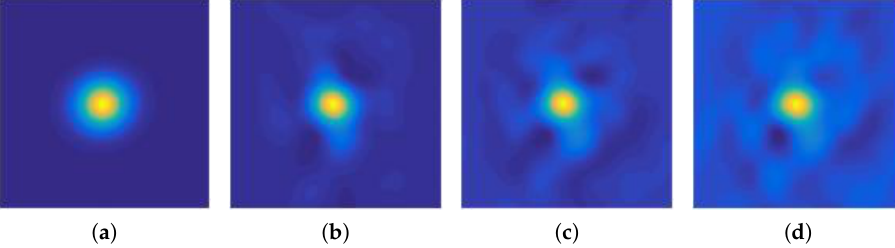
Figure 8. All four weak response maps: ( a ) Conv 5-4 Response; ( b ) Conv 4-4 Response; ( c ) Conv 3-4 Response; ( d ) AS 3D HOG